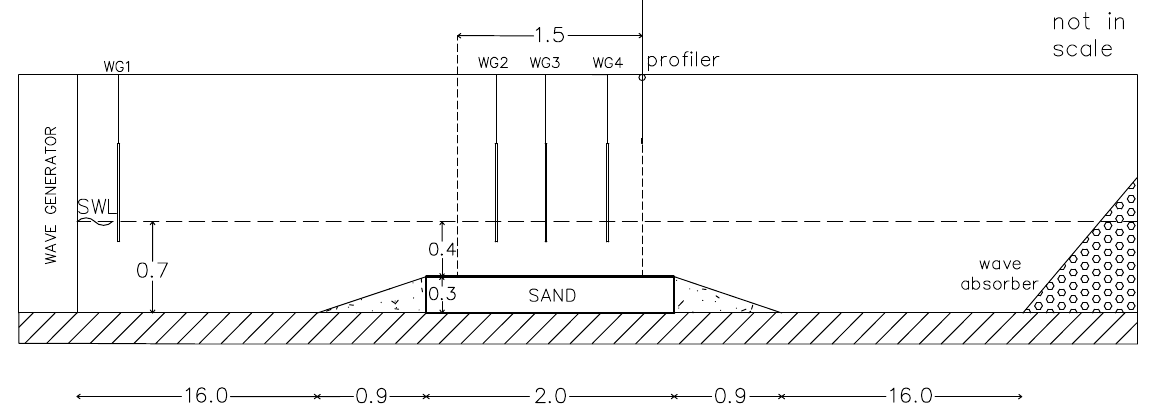
Figure 5. Side view of experimental setup of the horizontal seabed model.